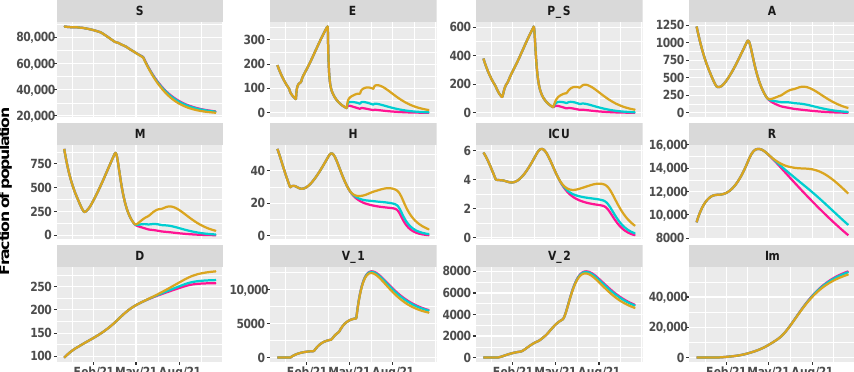
Figure 12. Projections of the epidemic evolution with a vaccination schedule of 800,000 first doses of vaccines per day in Italy (medium vaccination). Each line corresponds to a different reopening strategy, i.e., different values of transmission rate parameters b e and b 0 (yellow for high values, blue for medium values, and pink for low values.)